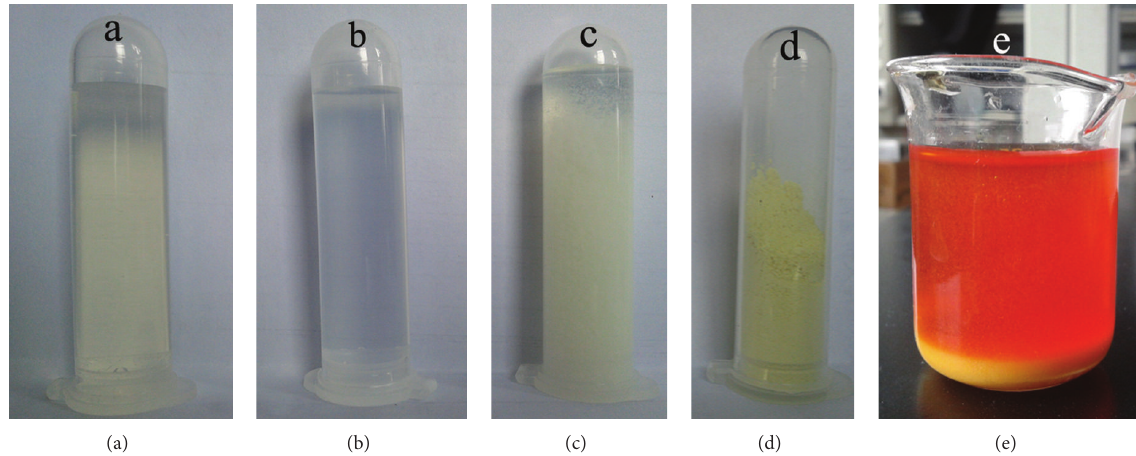
Figure 1: (a) Reaction product of Ti and H 2 O 2 (30%). (b) Reaction product of Ti and NaOH (10mol/L). (c) Reaction product of Ti, H 2 O 2 , and NaOH before washing. (d) Reaction product of Ti, H 2 O 2 , and NaOH after washing, being dried, and grinding. (e) Add hydrochloric acid in reaction product of Ti, H 2 O 2 , and NaOH (pH < 7).